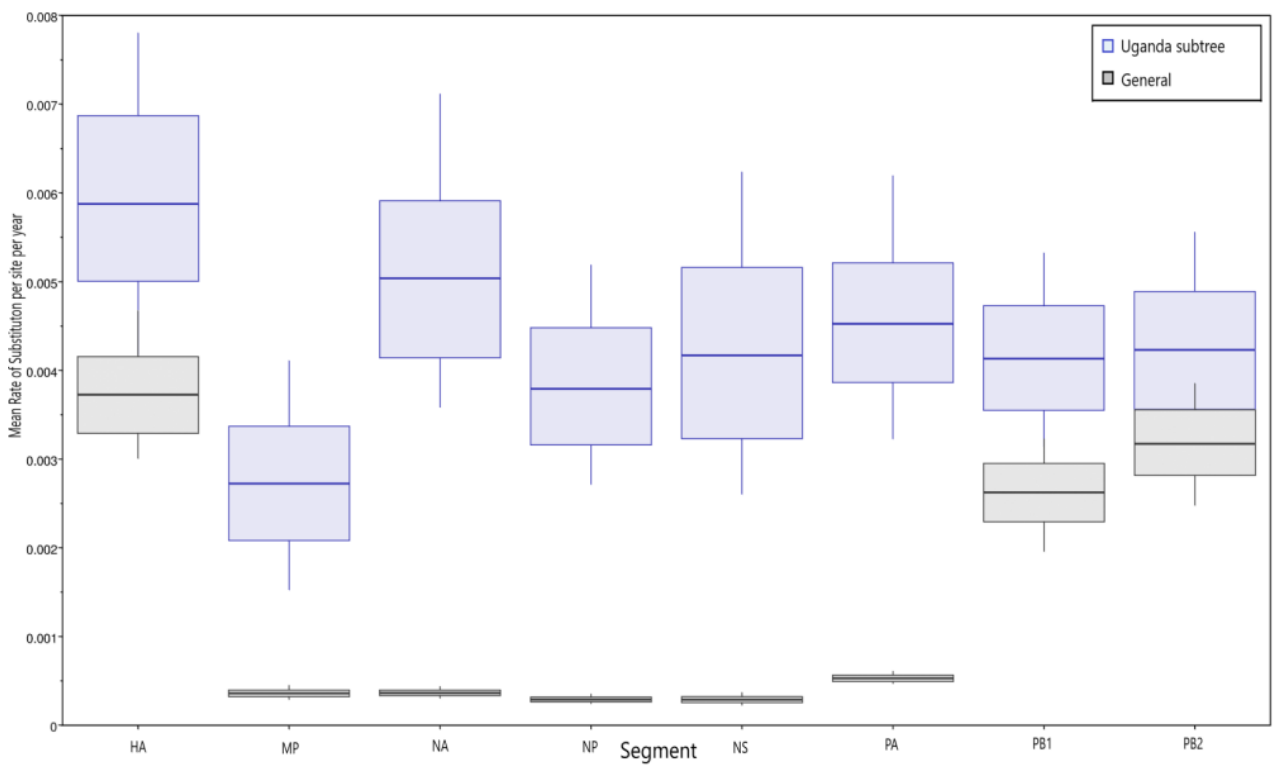
Figure 2. Comparing the mean rate of substitutions of the segments in Ugandan viruses and the rest. Ugandan viruses had a higher-than-average substitution rate.